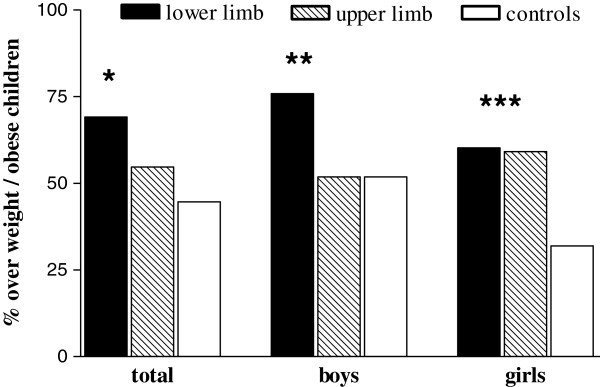
Prevalence of overweight/obesity in children with lower, or upper limb fractures and controls. The chi-squared test was used to compare the proportions of overweight/obese children among groups. *p = 0.045 lower vs upper limb; p < 0.002 lower limb vs controls; p < 0.05 upper limb vs controls. **p < 0.01 lower limb vs upper limb; p < 0.02 lower limb vs controls. ***p < 0.004 lower and upper limb vs controls.